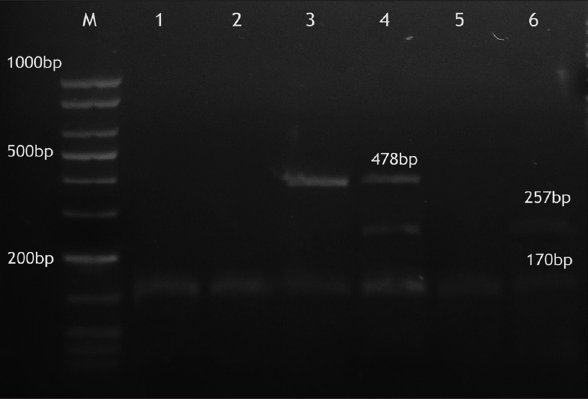
Figure-2: Enterotoxin genotyping pattern of examined six Staphylococcus aureus strains, DNAmarker low range 50 bp (Jena